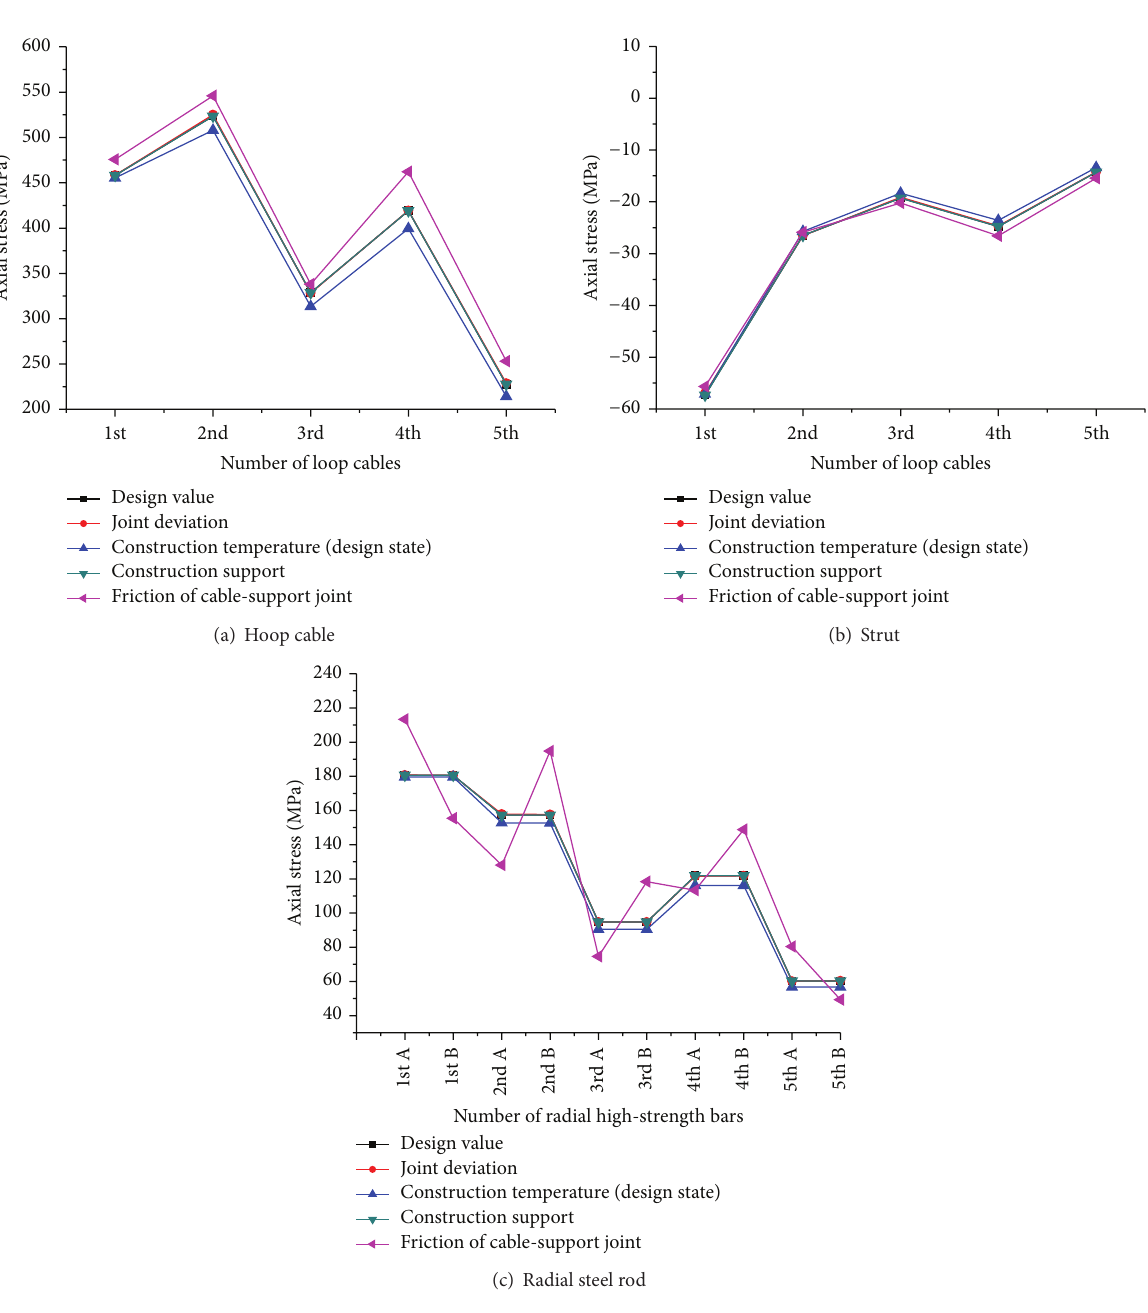
Figure 13: Axial stress of hoop